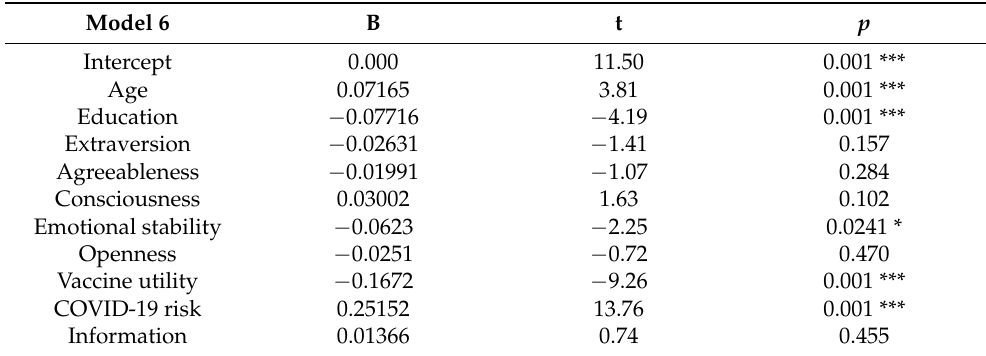
Table 3. Regression analysis: variables for